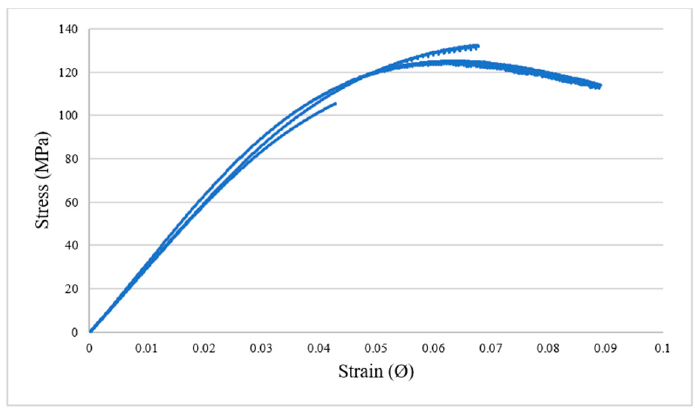
Figure 5. 3-point bending curves for three tested specimens. Maximum bending stress vs.; strain (ep / CA / DMID 1 / 0.8 / 0.025). Table 4. Three-point bending properties of epoxy thermoset (ep / CA / DMID 1 / 0.8 / 0.025). Mean Value ± Standard Deviation Modulus Ultimate Stress Strain at Failure